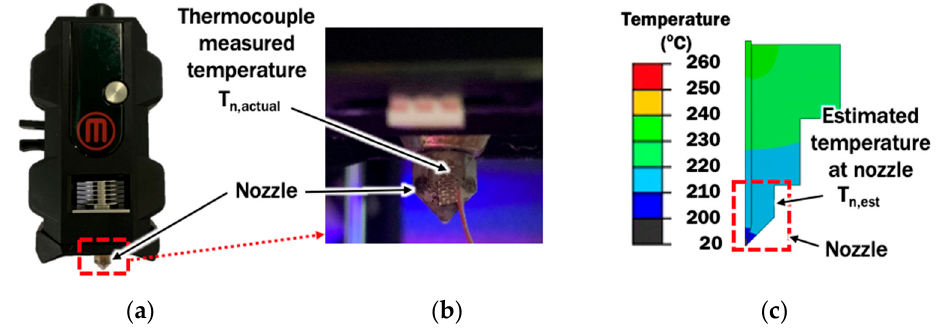
Figure 4. Temperature measurement at nozzle: ( a ) Location of nozzle at the extruder unit; ( b ) Lo- cation of the thermocouple at nozzle; ( c ) Estimated temperature at the corresponding location of thermocouple in FE model.